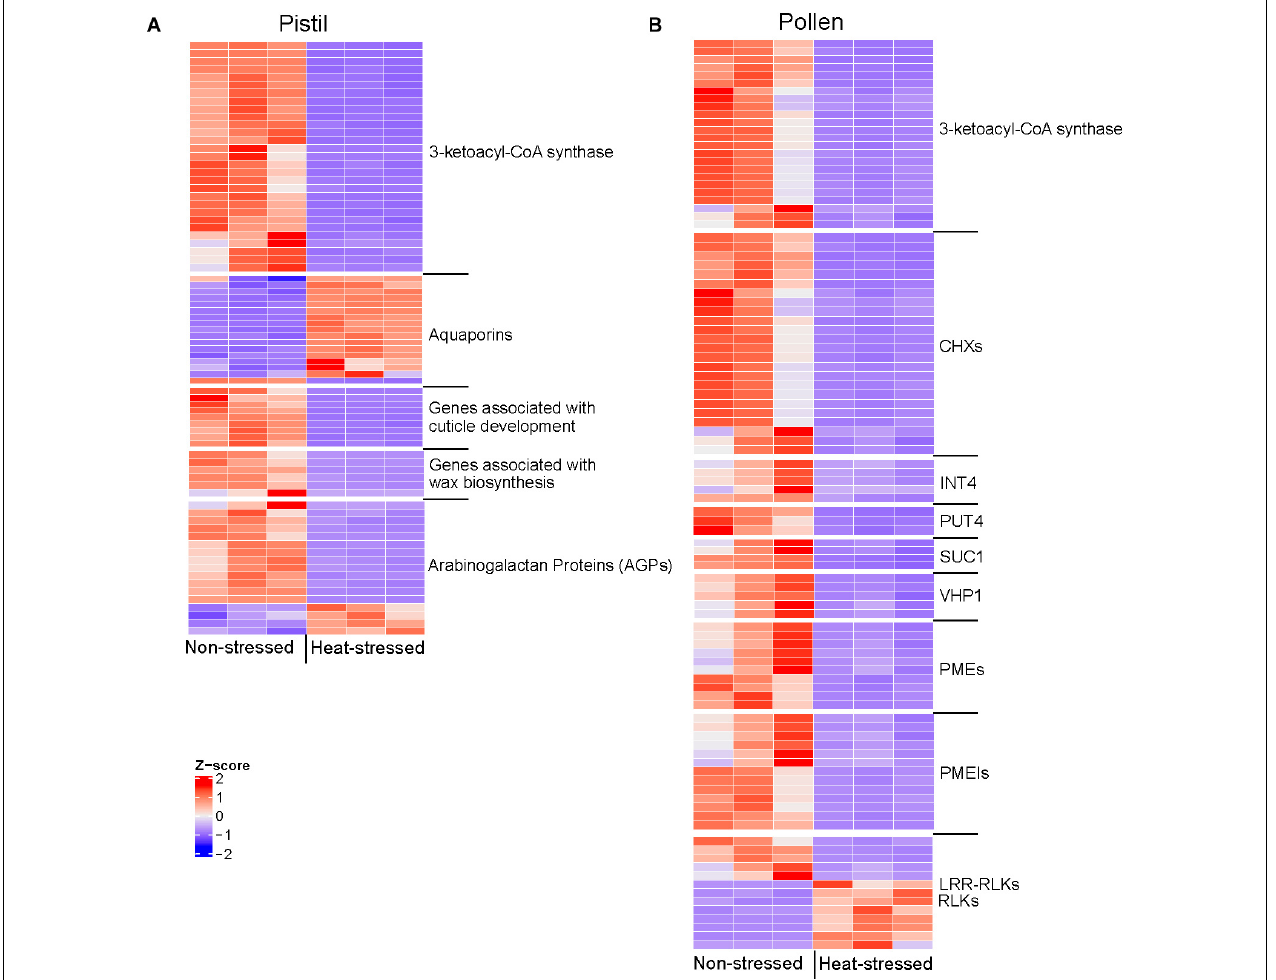
FIGURE 8 | (A) Expression of selected genes differentially regulated in heat-stressed pistil possibly involved in pollen-pistil interactions. (B) Expression of selected genes differentially regulated in heat-stressed pistil possibly involved in pollen-pistil interactions. See the summary in Supplementary Tables S3a–f, S4a–f for log 2